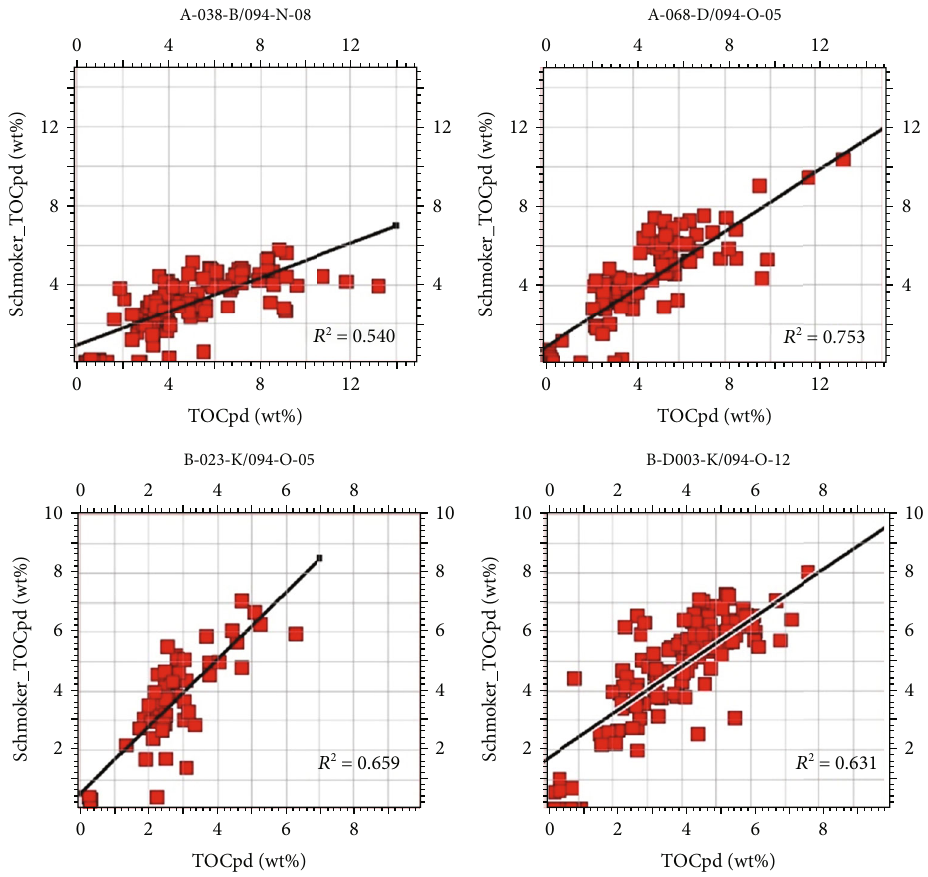
Figure 8: Correlation between calculated TOCpd (Schmoker_TOCpd) and measured TOCpd of A-038-B/094-N-08 [17] and A-068-D/094- O-05 [18], and B-023-K/094-O-05 [19] and B-D003-K/094-O-12 [19]. Coe ffi cients of determinations are from 0.540 to 0.753; these value means that the Schmoker_TOCpd has a substitute instead of measured TOCpd in boreholes without geochemical